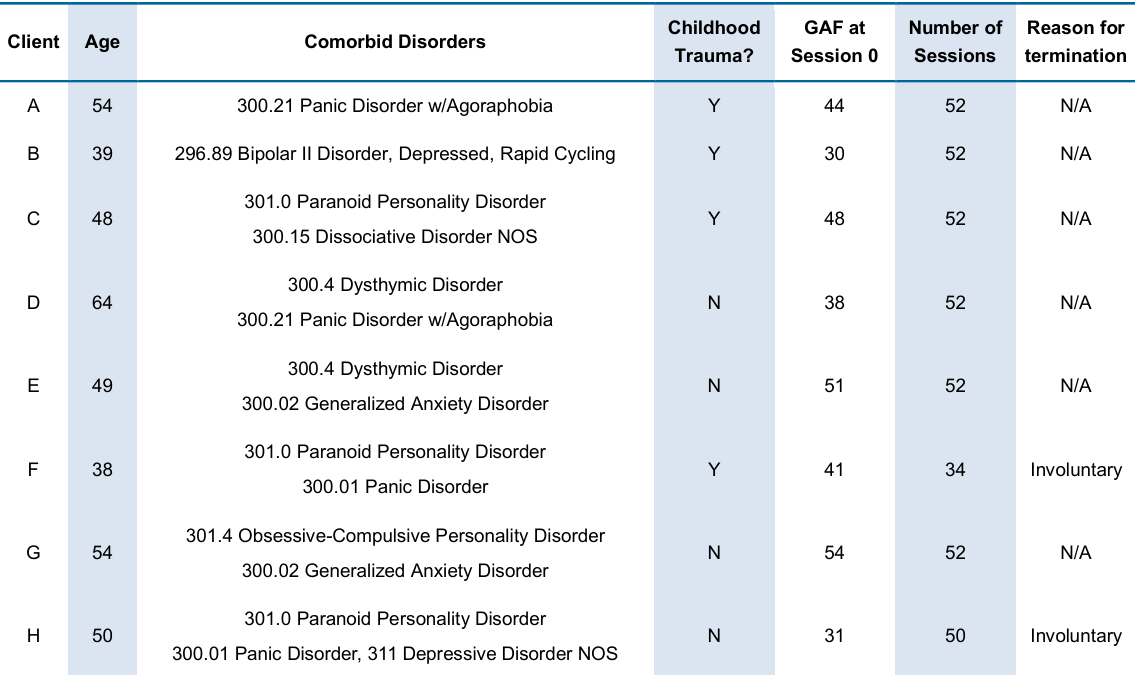
Table 2: Characteristics of sample undertaking long term therapy